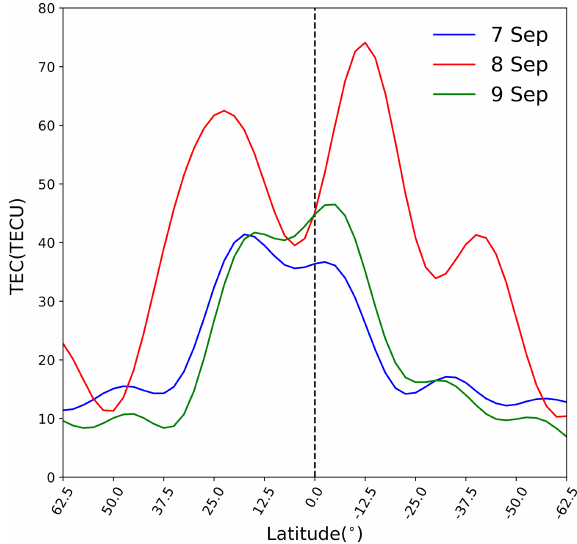
Figure 4. Structure of the VTEC for the 170 ◦ E meridian at 02:00 UT between 7 and 9 September 2017. A relevant range of latitudes is shown (62.5 ◦ N–62.5 ◦ S). The vertical dashed black line indicates the Equator (latitude = 0 ◦